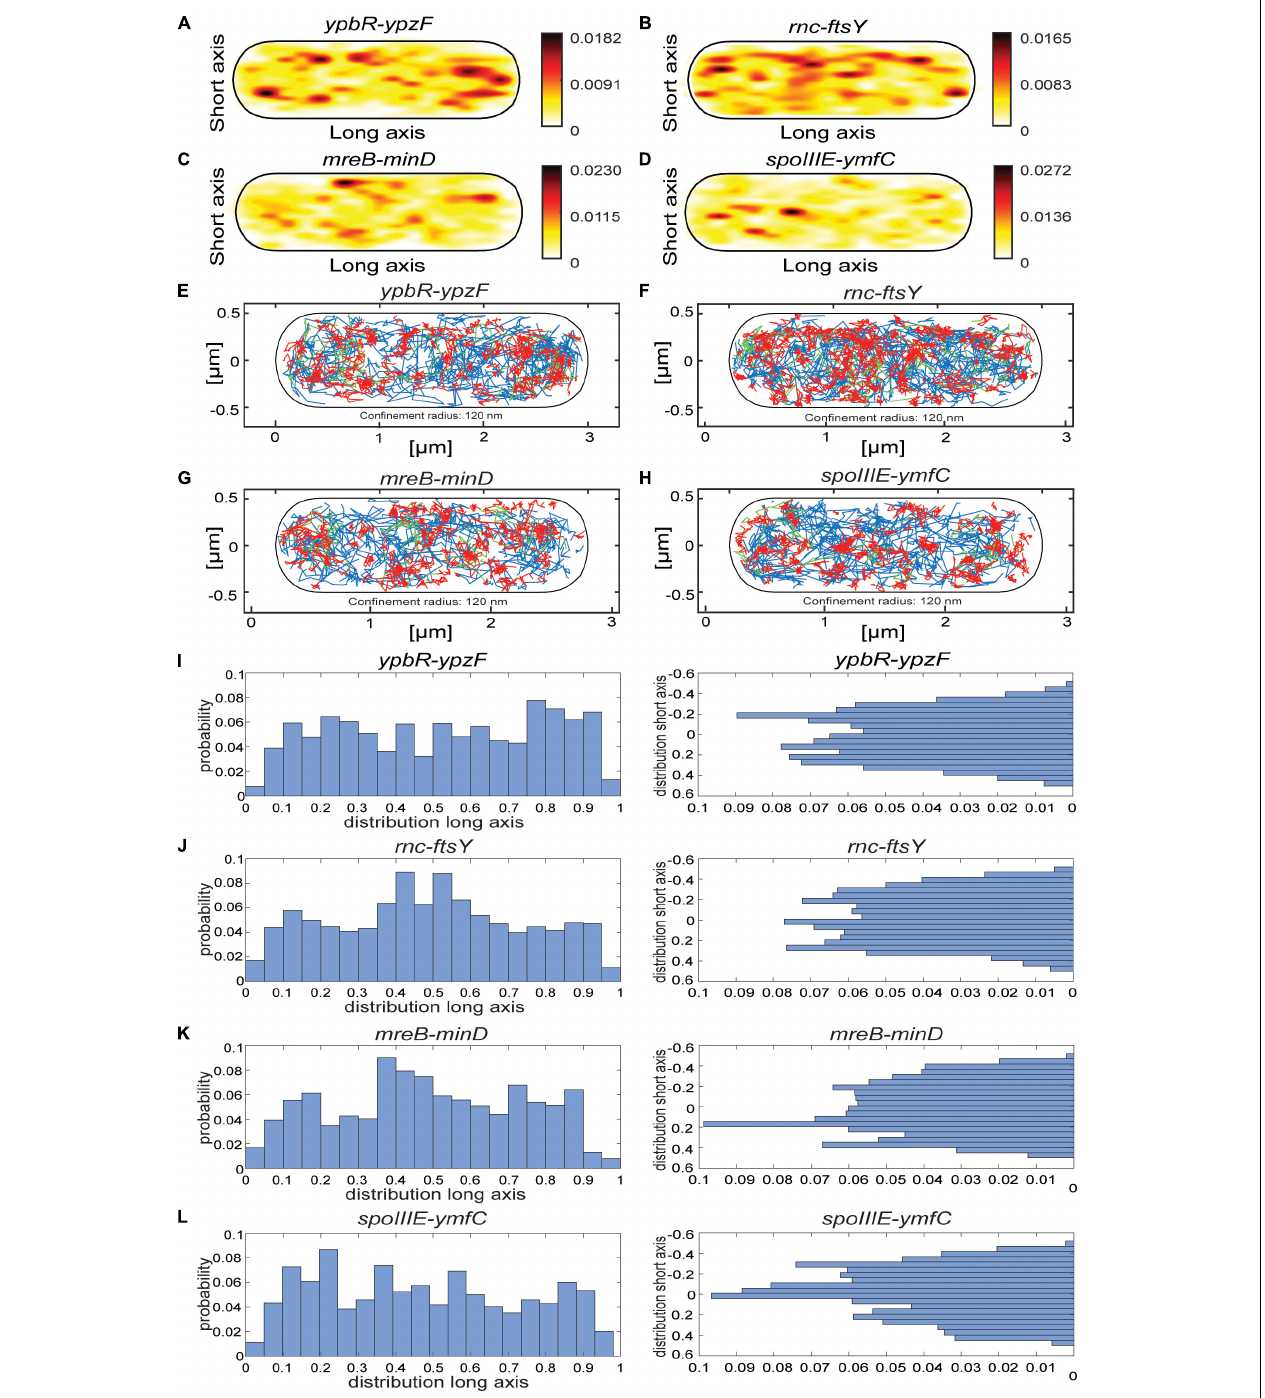
FIGURE 5 | Localization patterns of different mRNAs tagged with two MS2-binding sites. All tracks of MS2-mVenus bound to 2 × MS2-binding site tagged mRNAs are projected into a standardized cell of 1 × 3 µ m. For heat maps, white to red represent low to high probability of localization of molecules. (A) MS2-mVenus + ypbR-ypzF _MS2–binding site 2 × , (B) MS2-mVenus + ftsY _MS2–binding site 2 × , (C) MS2-mVenus + mreB-minD _MS2–binding site 2 × , (D) MS2-mVenus + spoIIIE-ymfC _MS2–binding site 2 × . For confinement maps, blue represents freely diffusive tracks, red tracks restricted to a confined motion within a 120-nm circle for a minimum of eight steps, and green tracks with mixed behavior between mobile and confined motion. (E) MS2-mVenus + ypbR-ypzF _MS2–binding site 2 × , (F) MS2-mVenus + ftsY _MS2–binding site 2 × , (G) MS2-mVenus + mreB-minD _MS2–binding site 2 × , and (H) MS2-mVenus + spoIIIE-ymfC _MS2–binding site 2 × . (I–L) Histograms showing the probability of confined tracks occurring along long ( x ) – or short ( y ) axis of cells. Histograms correspond to panels (E–H) .